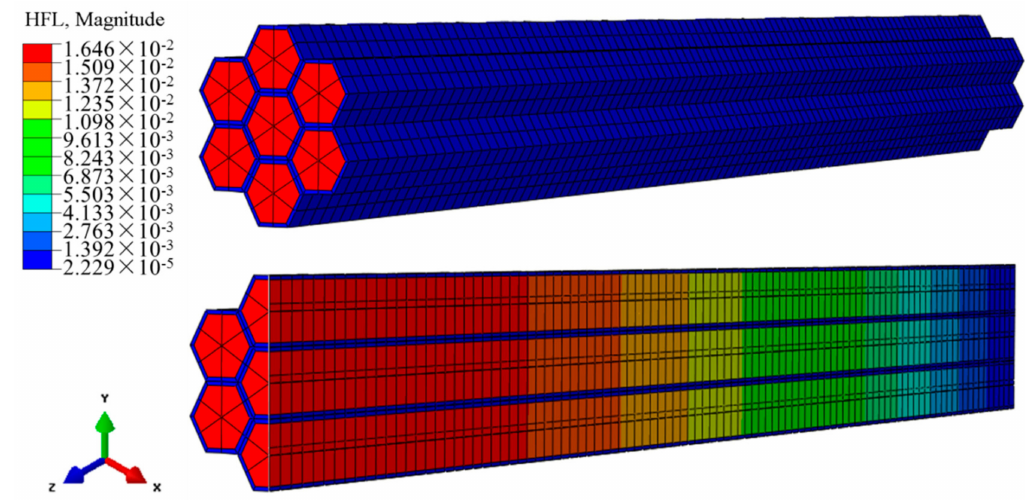
Figure 7. Heat flux in the model.